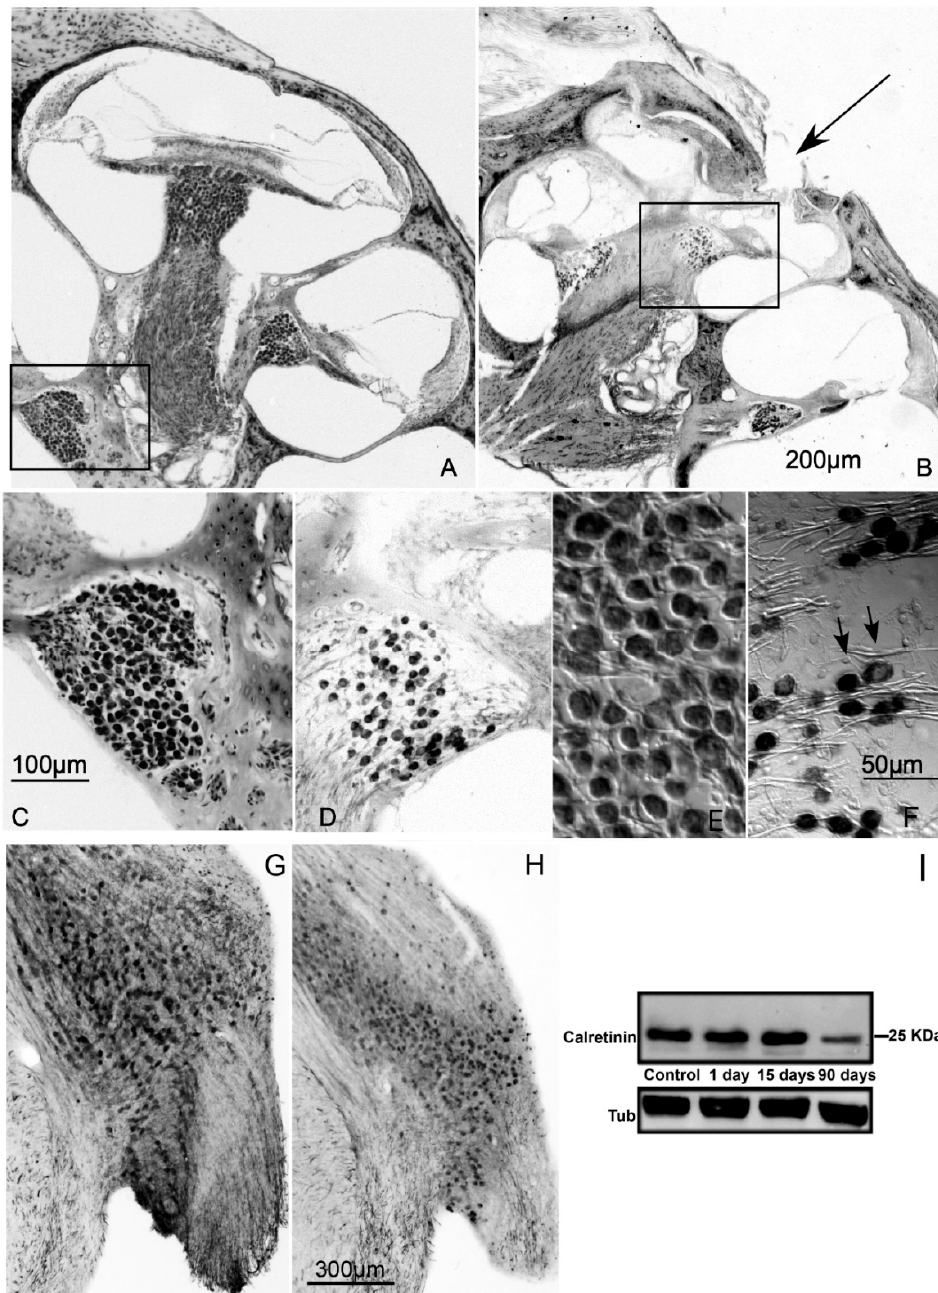
Figure 2. SGN loss after cochlear lesion. Nissl staining of the cochlea from a control rat ( A ) and at 90 days after cochlear lesion ( B ). The arrow indicates the site of lesion. ( C , D ) SGN cell bodies from the box insets shown in A and B respectively. A large decrease in SGN cell bodies is clearly visible in D. Details of SGN loss with time after lesion are given for this deafness model in the Results section and in (16). ( E , F ) High-magnification detail of normal SGN cell bodies ( E ) and ( F ) at 90 days post-lesion. Black arrows in F point to nuclear or cytoplasmic condensations in SGN bodies, a sign of neuronal degeneration. ( G , H ) Calretinin immunostaining on coronal sections of the AVCN, showing diminished fiber density at 90 days post-lesion ( H ) compared to controls ( G ). ( I ) Representative Western blot of the CN, showing diminished calretinin levels at 90 days after the cochlear lesion. Tubulin (Tub) was used as loading control. See the Results section for further details.